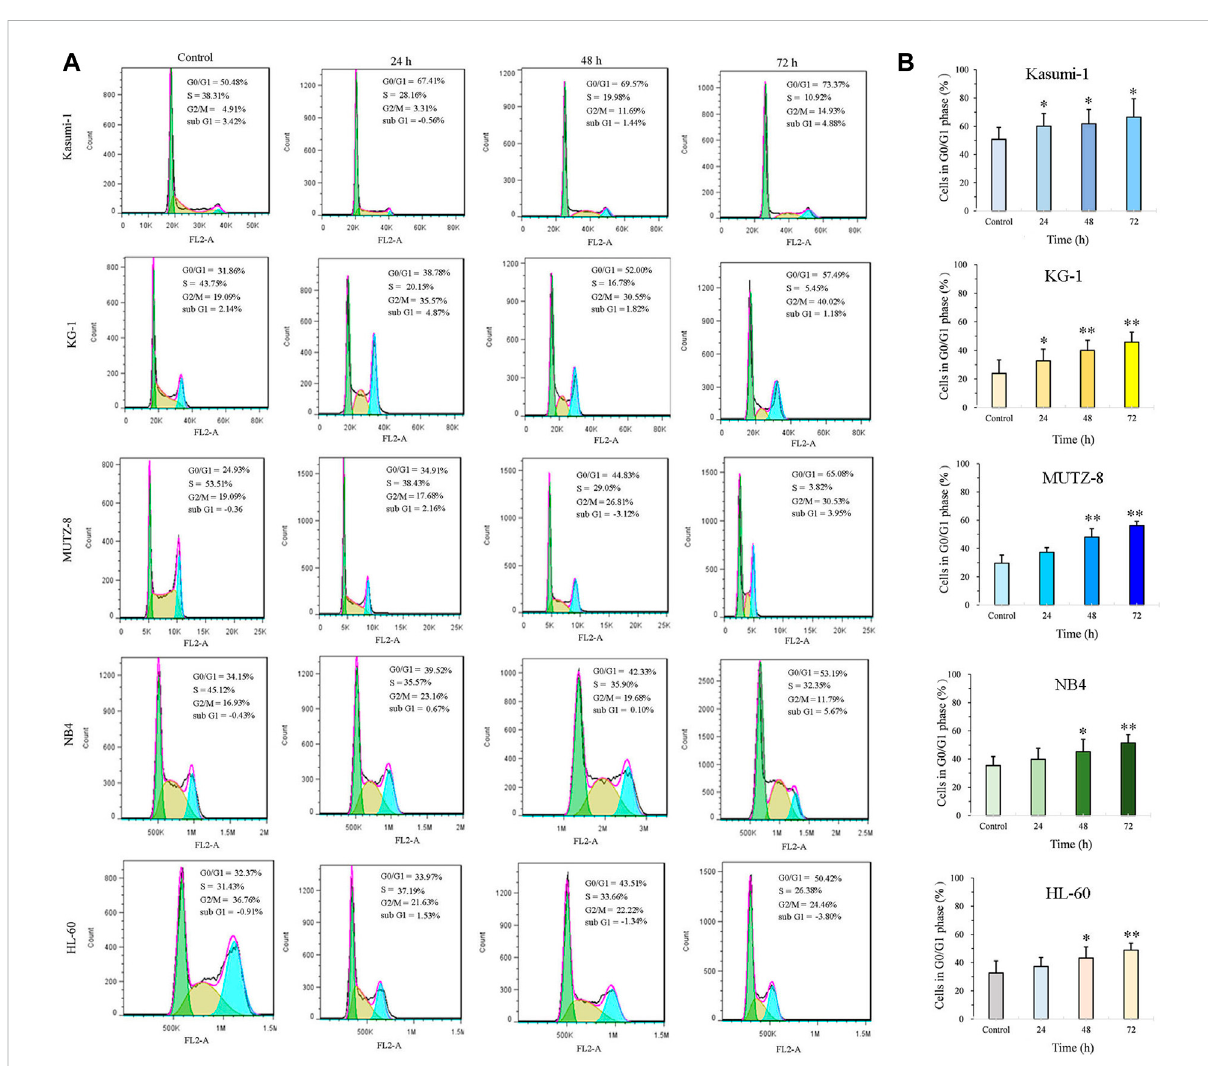
JOAinducedcellcycleexitattheG0/G1phaseinKasumi-1,KG-1,MUTZ-8,NB4,andHL-60cells. (A) EffectofJOAonthecellcycleofcells. (B) PercentageofG0/G1cellspresentedasabargraph(* p < 0.05and** p < 0.01).Kasumi-1,KG-1,MUTZ-8,NB4,andHL-60cellswereincubatedwith1, 1, 4, 1, or 1 μ M of JOA, respectively, for 24 h, 48 h, or 72